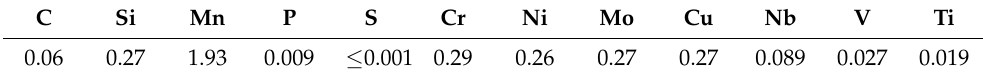
Table 1. Chemical composition of test steel